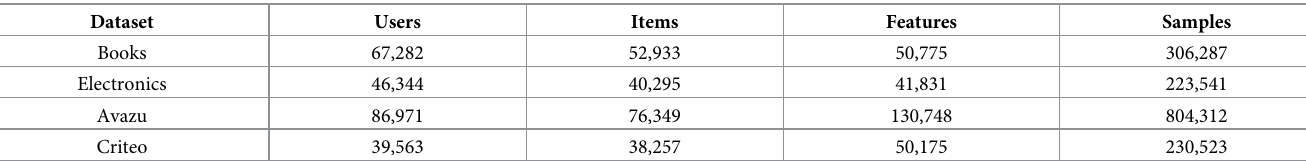
Table 1. Basic statistics of the